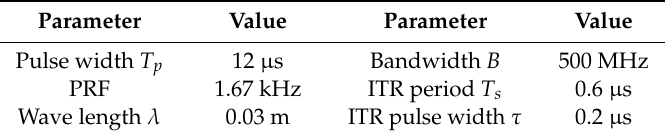
Table 1. Simulation parameters and